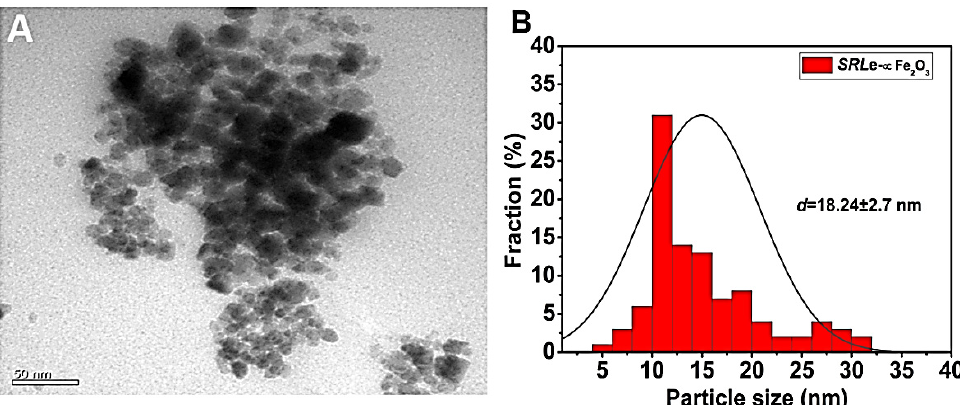
Figure 8. ( A ) Average particle size and size distribution of prepared SRLe - α Fe 2 O 3 NPs measured using TEM; (scale bar = 50 nm). ( B ) Size distribution data presented as the mean ± SD ( n = 3).